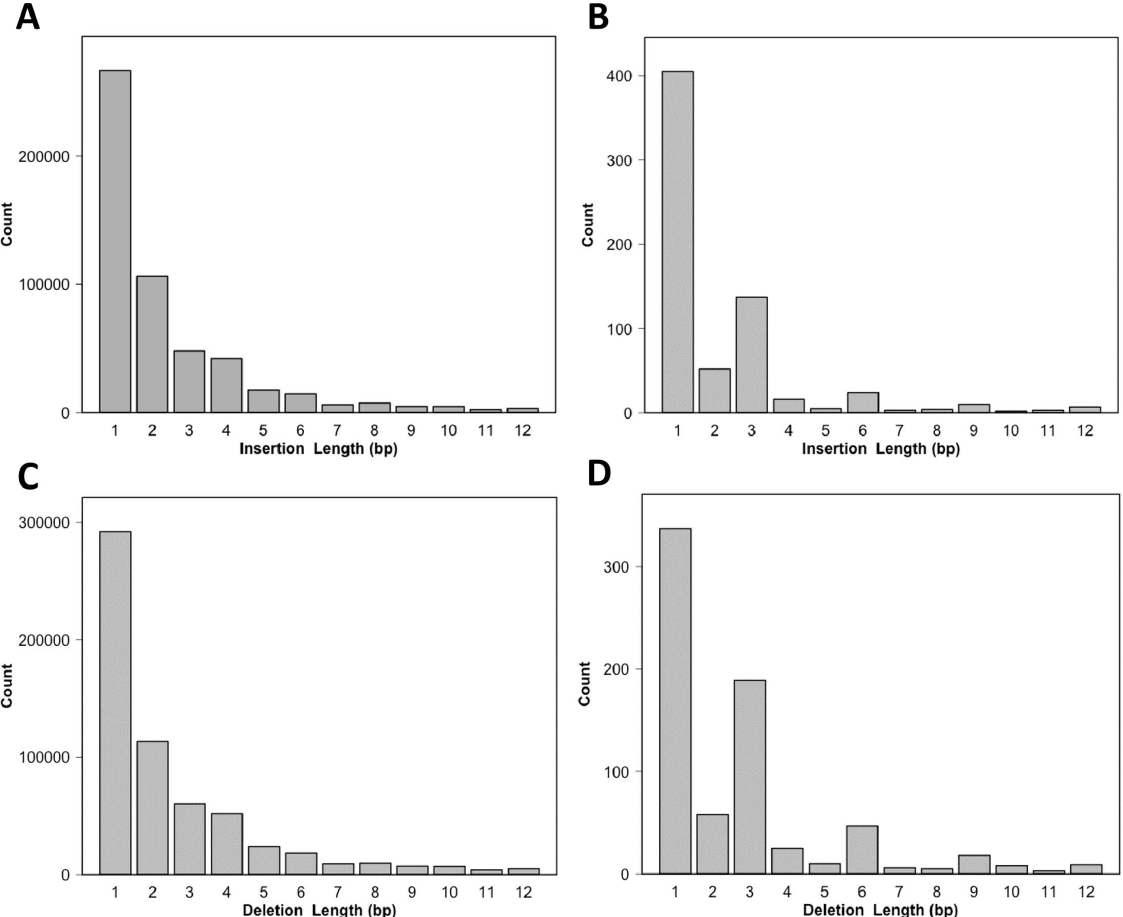
Figure 3. Length distribution of insertions–deletions (InDels) in this study. (A) Total insertion length distribution. (B) Distribution of insertions in coding regions. (C) Total deletion length distribution. (D) Distribution of deletions in coding regions.